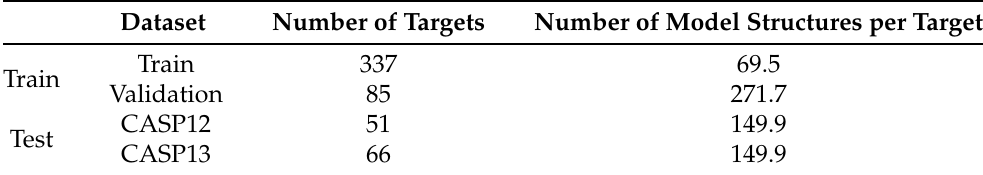
Table 1. Details of the training dataset and the test